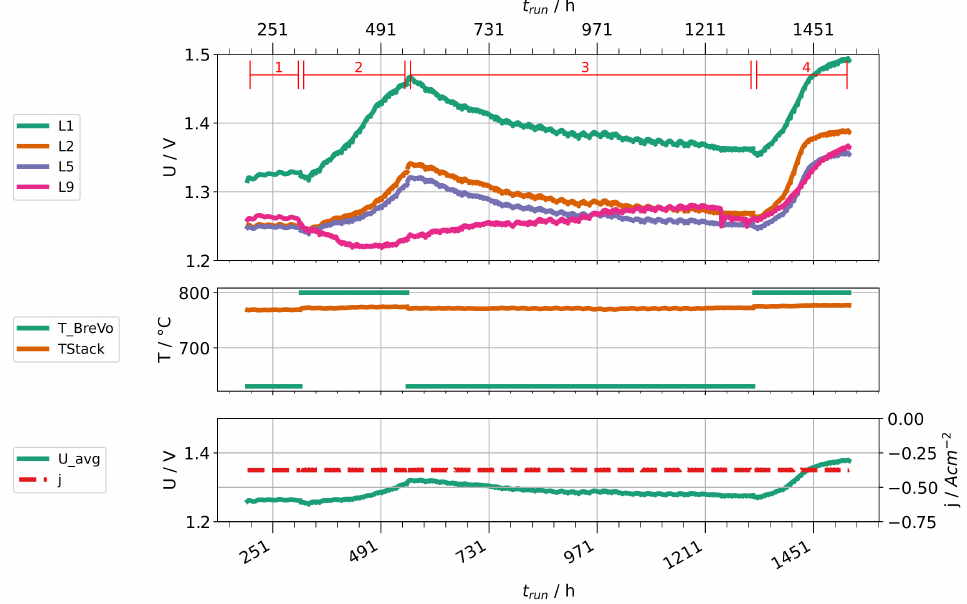
Figure 15. Time traces showing layer voltages, current densities, stack temperatures, and preheater operation temperatures for stack